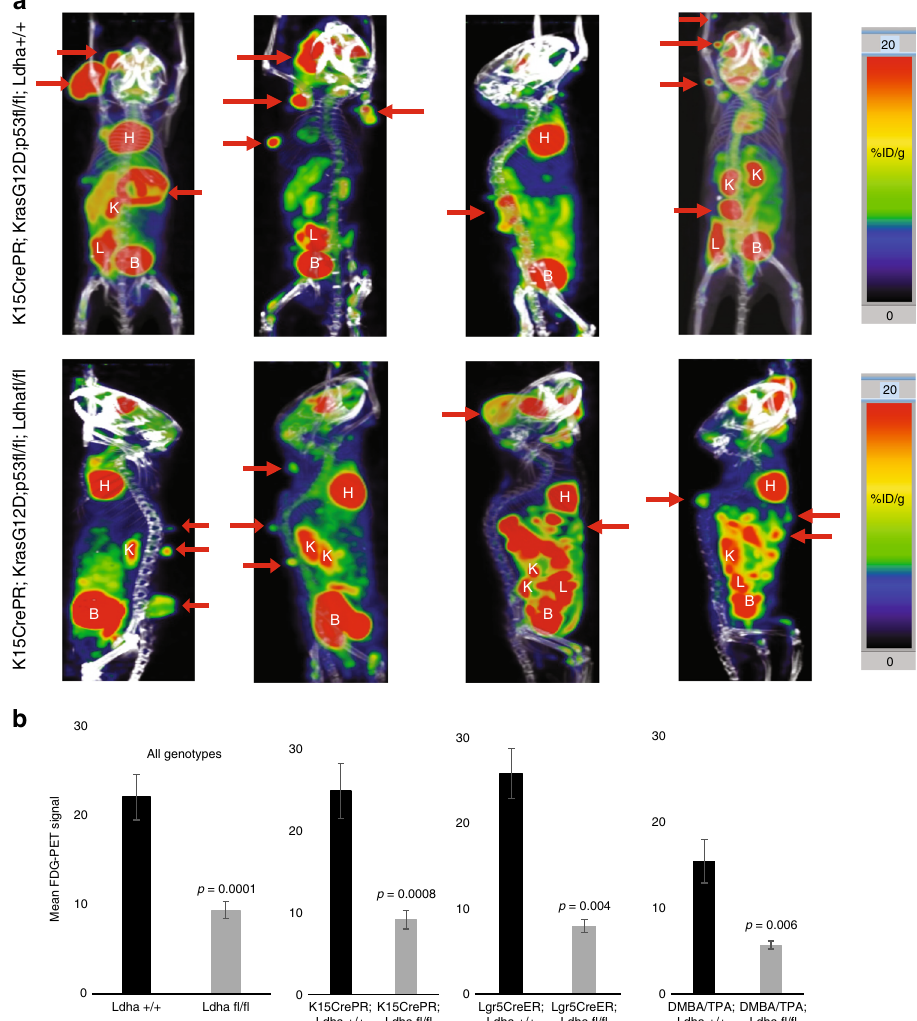
Fig. 4 Absence of Ldha leads to decreased Glucose uptake in tumors. a Positron Emission Tomography imaging after injection of FDG, a glucose analogue was used to demonstrate the relative degree of glucose uptake across tumors formed in the indicated genotypes. Red coloration indicates a high level of glucose uptake, and further demonstrates that SCC tumors are highly glycolytic. Red arrows indicate tumors. H = heart, K = kidney, L = liver, B = bladder. b Quanti fi cation of FDG-PET signal showed that Ldha null tumors (from either K15CrePR , Lgr5CreER , or DMBA/TPA mice) consistently show lower glucose uptake. Each bar represents the mean FDG-PET signal where n = 6 mice per genotype. Shown as mean ± SEM. Student ’ s paired t test was performed, P < 0.05 shown for knockout versus wild-type